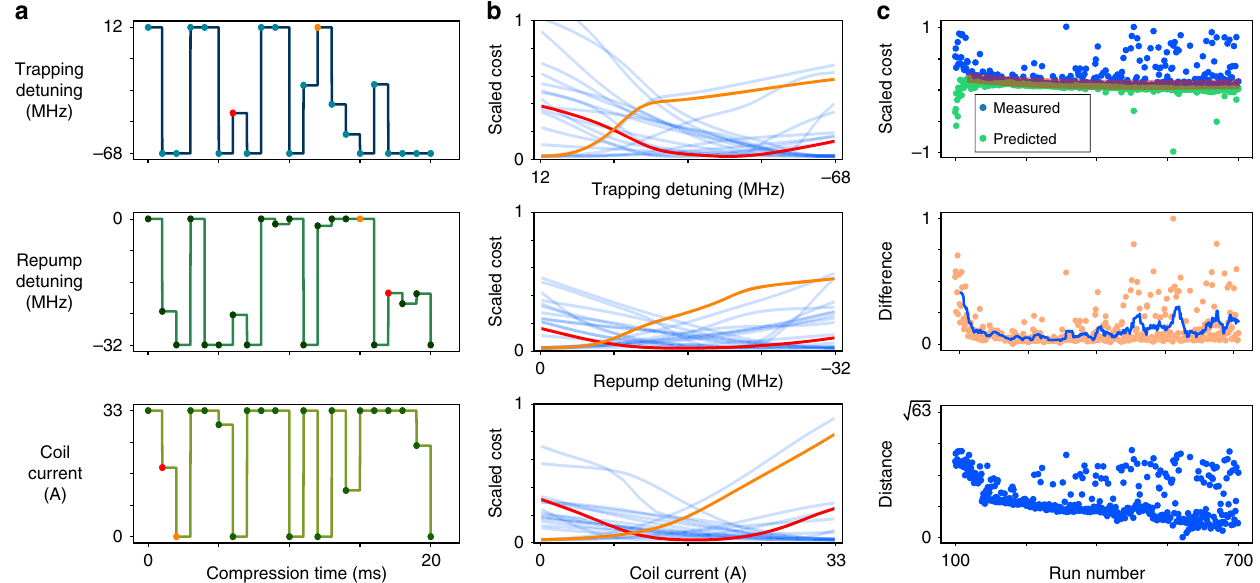
Fig. 4 Cost landscapes and convergence predicted cost landscape cross sections generated by the model after exploration of the parameter space. Each 1- dimensional slice ( b ) is generated by varying each parameter independently over the available range while keeping other parameter values constant at their best known value shown in a . The red and orange curves represent arbitrarily chosen points that demonstrate landscapes for intermediate values and boundary limited values respectively. The blue curves represent every other parameter not highlighted in the experimental run. c The convergence of the model is attained by observing the measured and predicted costs as shown in the top plot. The red shaded area corresponds to experimental noise. The middle plot shows the scaled difference between these two measurements and the associated moving average as the SANN explores different regions of the cost landscape. The lower plot shows the distance of a given parameter set from the best observed parameter set